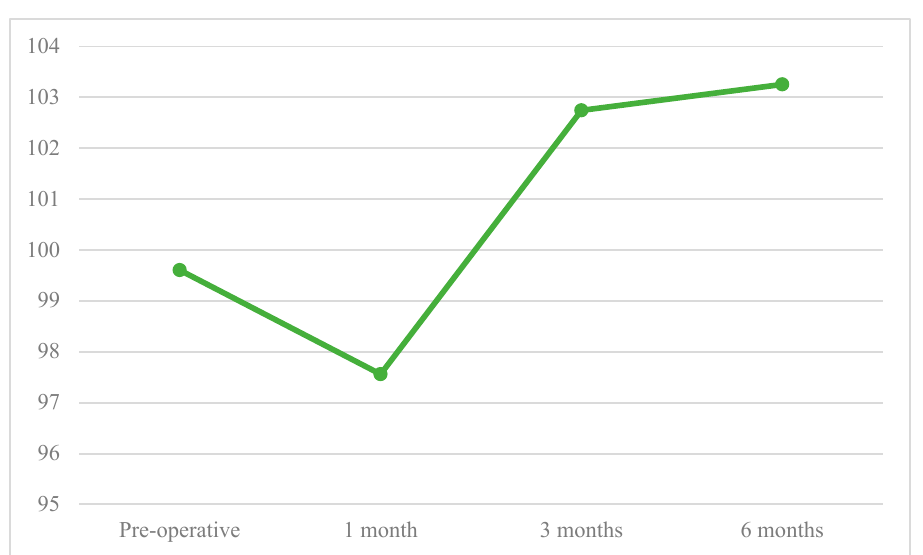
Figure 3. SF-36 follow-up.